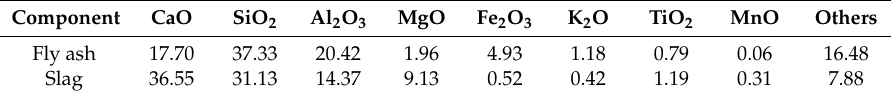
Table 2. The chemical compositions of slag and fly ash detected by